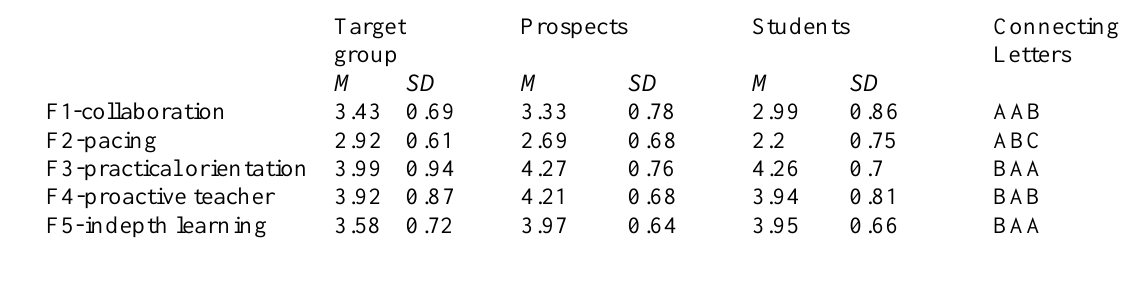
Mean, Standard Deviation and Connecting Letters (Tukey-Kramer HSD) of the Factor-Based Scales for the Three